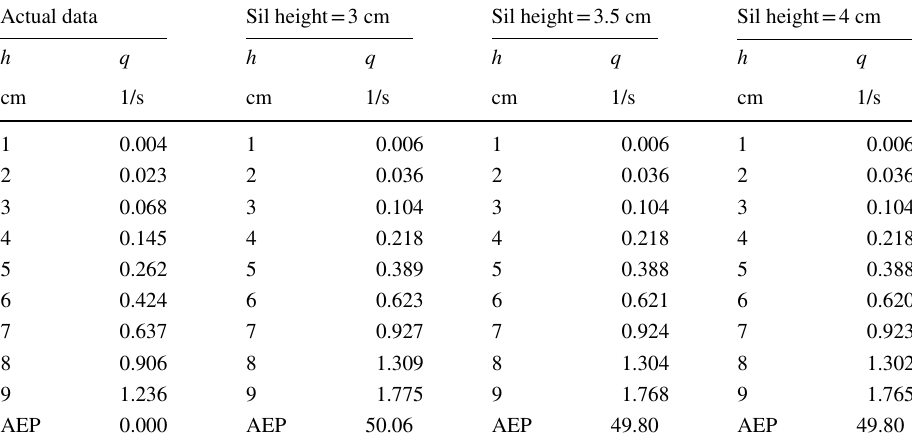
Table 3 Error percentage values resulting in discharge estimation by WinFlume software